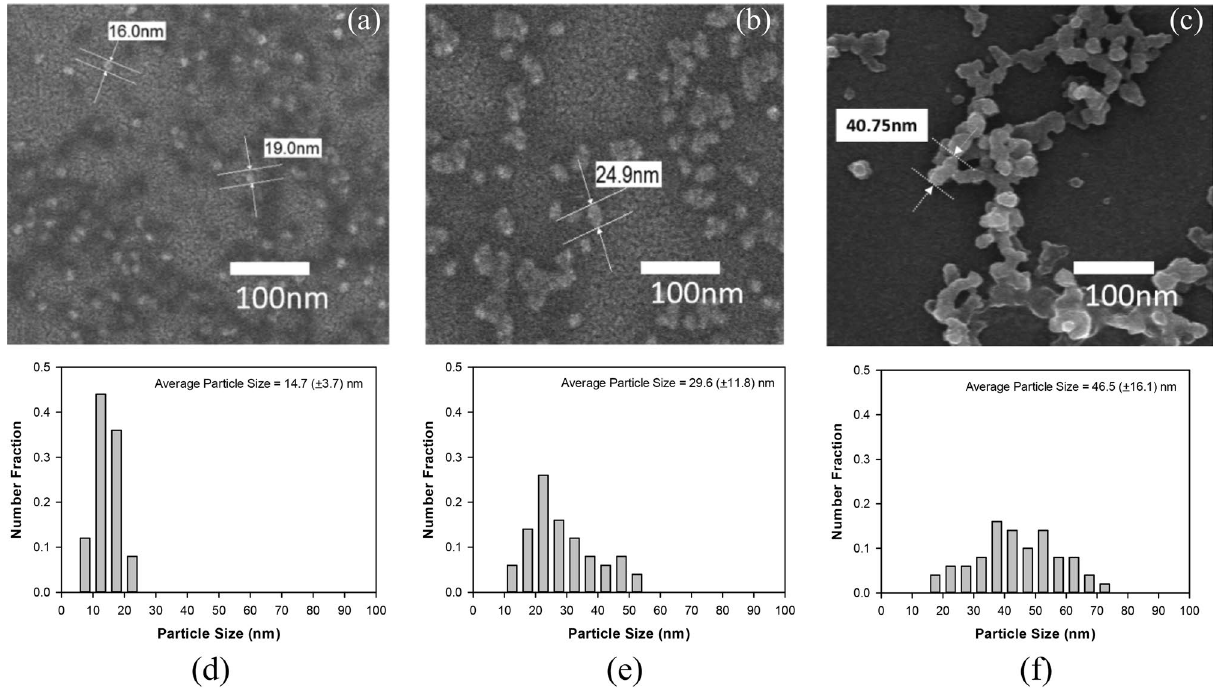
Figure 2. FE-SEM images of ( a ) QDs/SA, ( b ) QDs/SA-Ab, ( c ) QDs/SA-Ab-Ag, and particle size distributions of ( d ) QDs/SA, ( e ) QDs/SA-Ab, and ( f ) QDs/SA-Ab-Ag.